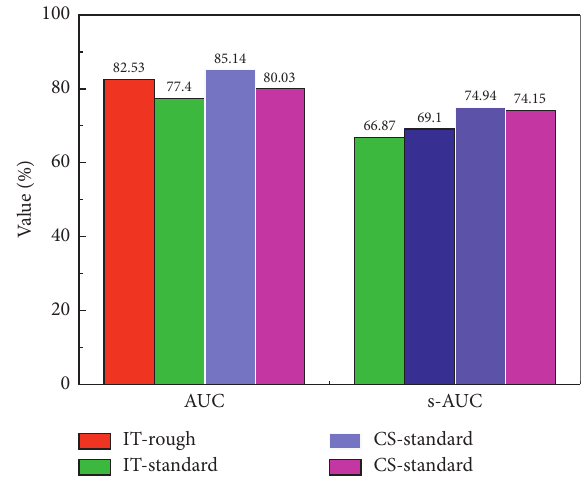
Figure 9: The AUC and s-AUC values of the CS model on the BSDS500 data set.